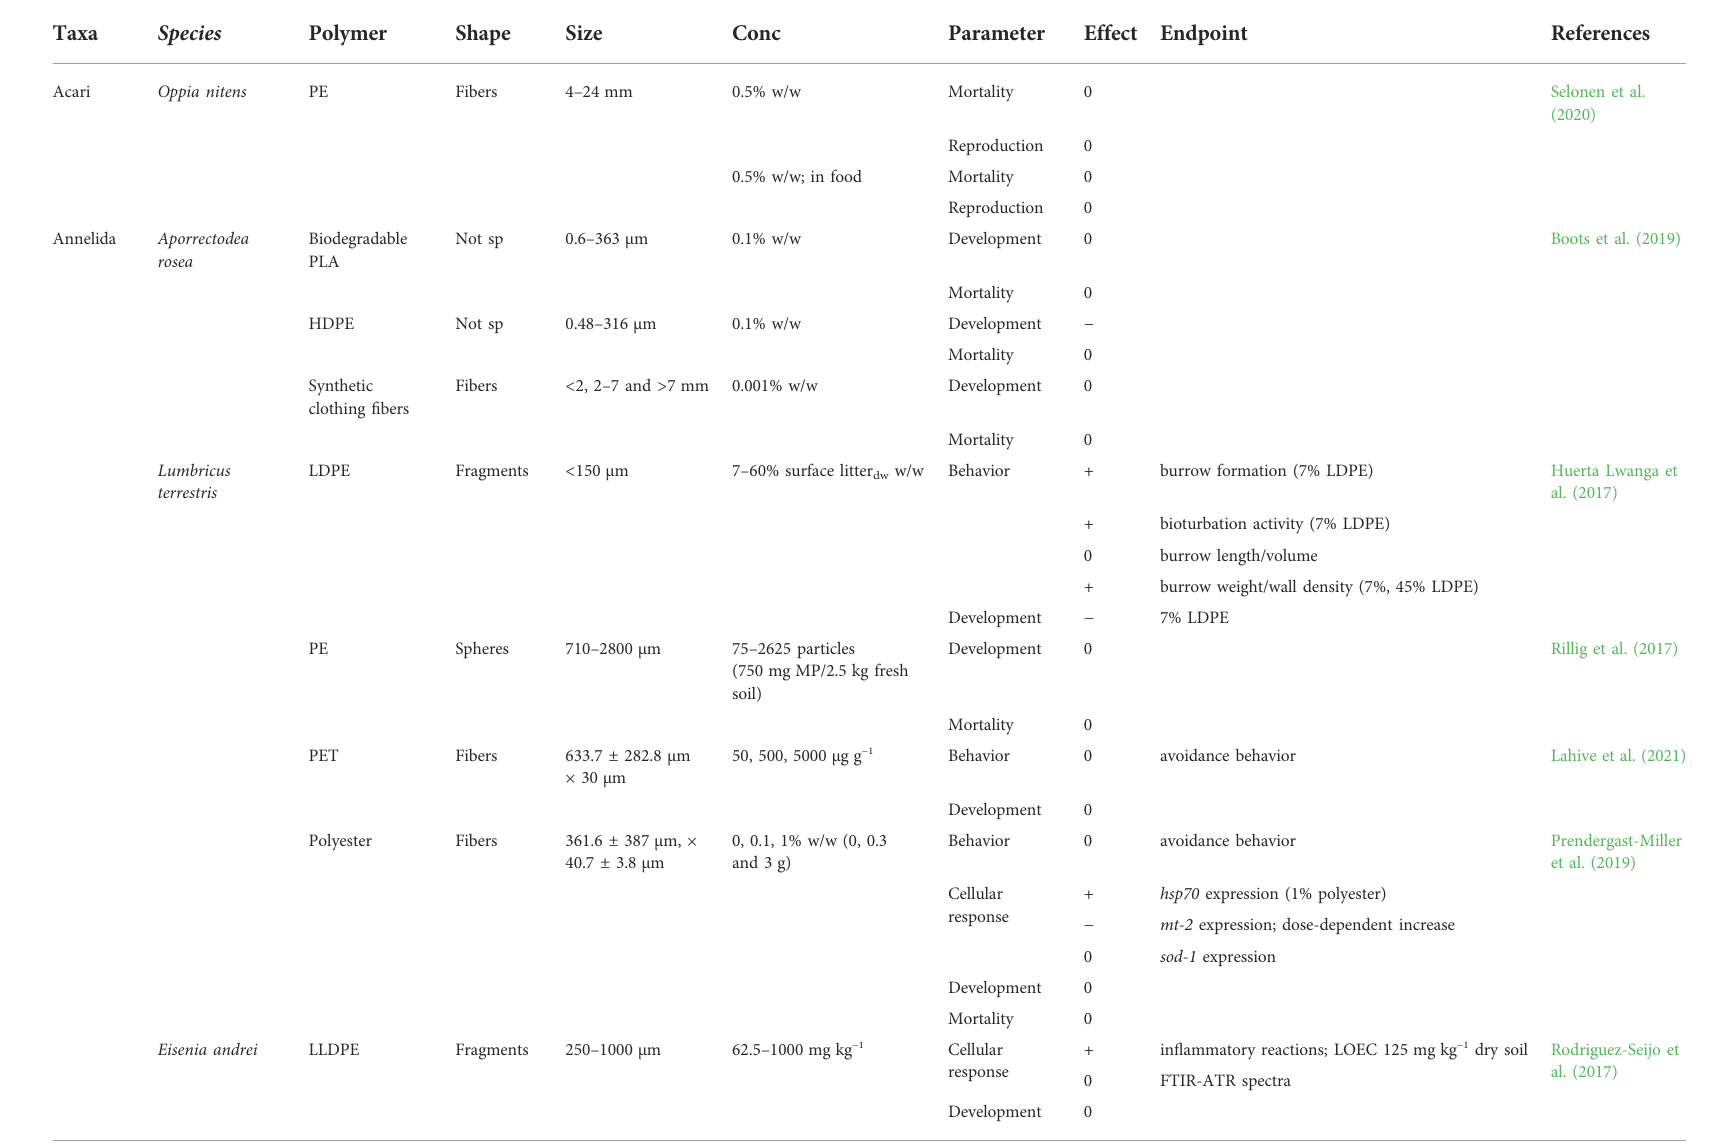
TABLE 4 Effects of macro-, micro- and nanoplastics on soil